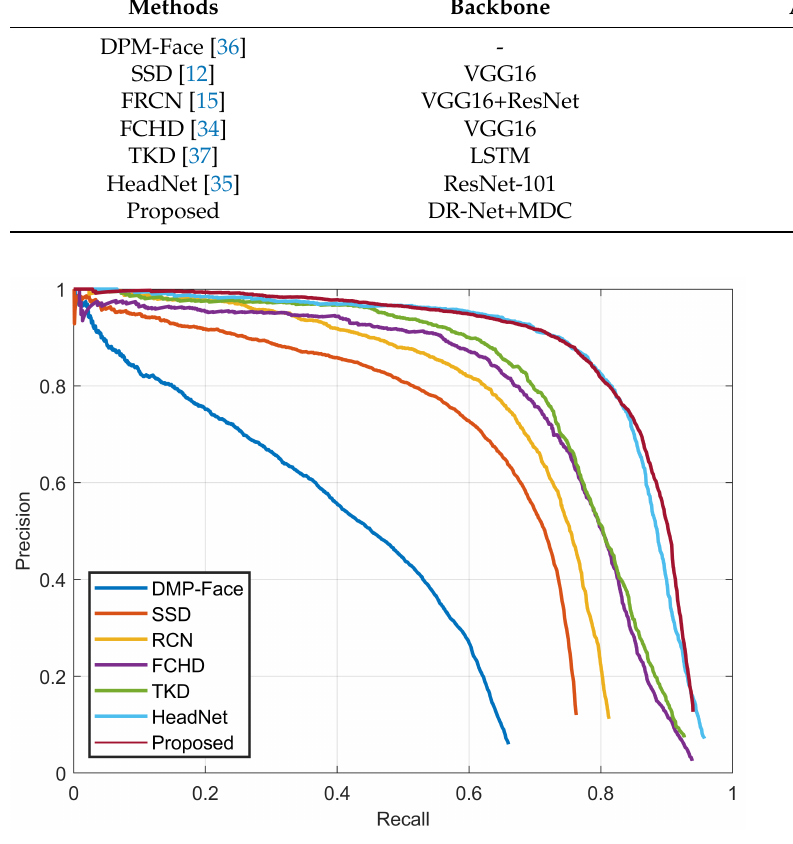
Figure 10. The PR curves of our method versus other methods from the experiments on the Holly- woodHeads